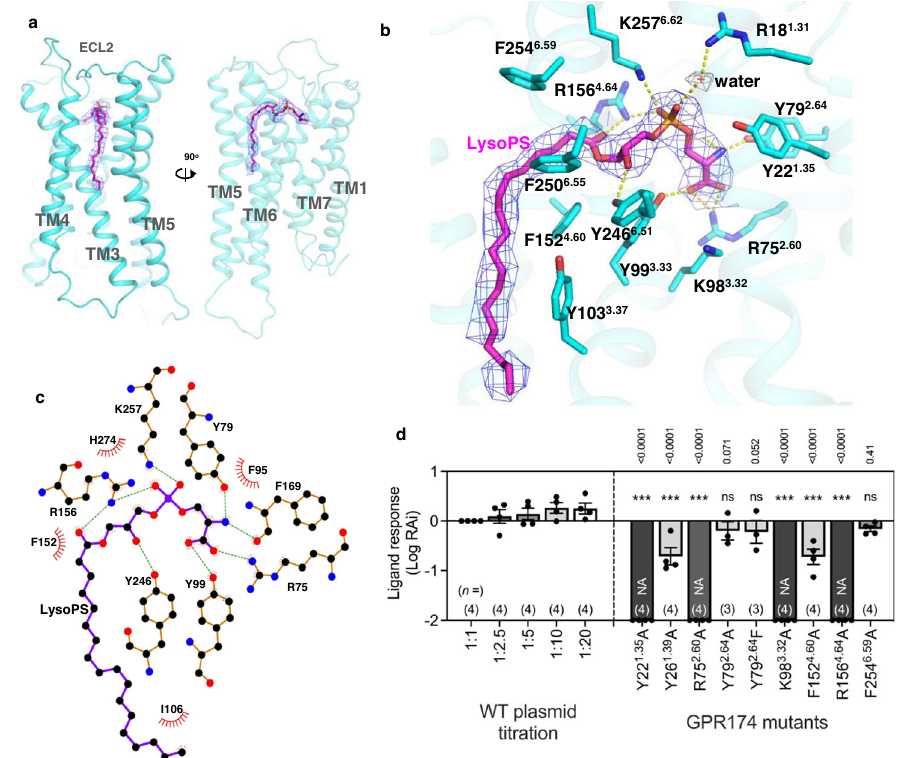
Fig. 2 | Ligand binding pocket ofGPR174. a The overall structure of GPR174 with LysoPSligandinit(magentacolor). b Anenlargedviewoftheligandbindingpocket focused on the head of LysoPS (magenta). Density map of the ligand (blue mesh) andwater(graymesh)issetatacontourlevelof5.0inpymol. c Aninteractionplot of LsyoPS head group and key residues of receptor – ligand binding pocket by LigPlot. Green line, polar interaction; eyelash shape, hydrophobic interaction. d LigandresponseofGPR174mutants( Δ pEC 50 toWTGPR174).Datawereplottedas